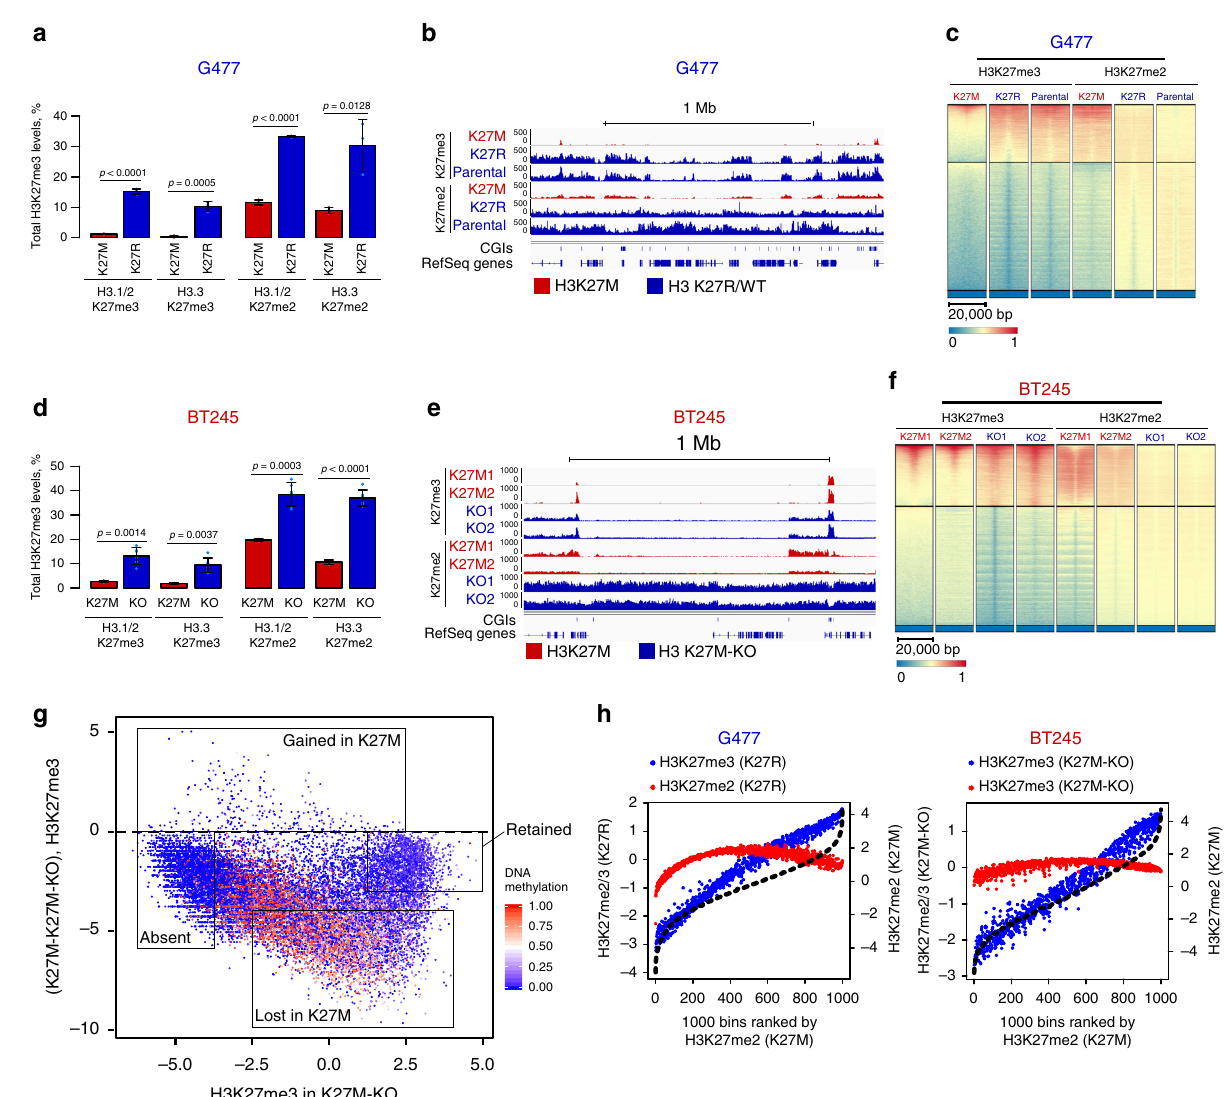
Fig. 2 H3K27M reversibly induces global redistribution of H3K27me2 and H3K27me3 ( a – c ). G477 wild-type cell line with H3.3-K27M overexpression. a H3K27me2/3 abundance by histone mass spectrometry ( n = 3 in each group, mean ± standard deviation, Student ’ s t -test). b Example ChIP-seq tracks of H3K27me2/3 distribution, normalized by drosophila spike-in (ChIP-Rx). c Heatmap plots of ChIP-seq signal intensity for H3K27me2 and H3K27me3 over CGIs for parental G477 (wild-type) and G477 overexpressing K27R and K27M. CGIs are separated by kmeans clustering ( k = 3). d – f . BT245 with H3K27M knockout (KO) by CRISPR/Cas9. d H3K27me3 abundance by histone mass spectrometry (K27M n = 3, KO n = 6, mean ± standard deviation, Student ’ s t - test). Whiskers represent standard deviation. e Example ChIP-seq tracks of H3K27me2/3 distribution, ChIP-Rx normalized. f Heatmap plots of ChIP-seq signal intensity for H3K27me2 and H3K27me3 over CGIs for parental BT245 (H3K27M) and K27M knockout (K27M-KO) by CRISPR. CGIs are